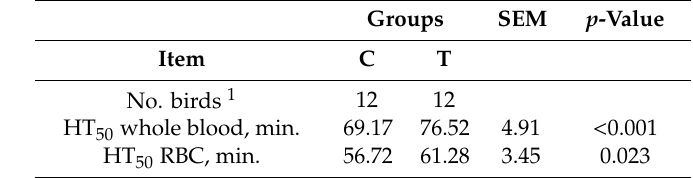
Table 3. E ff ects of plant extract supplementation on total antioxidant activity. Data shown as LSMeans ± SEM.